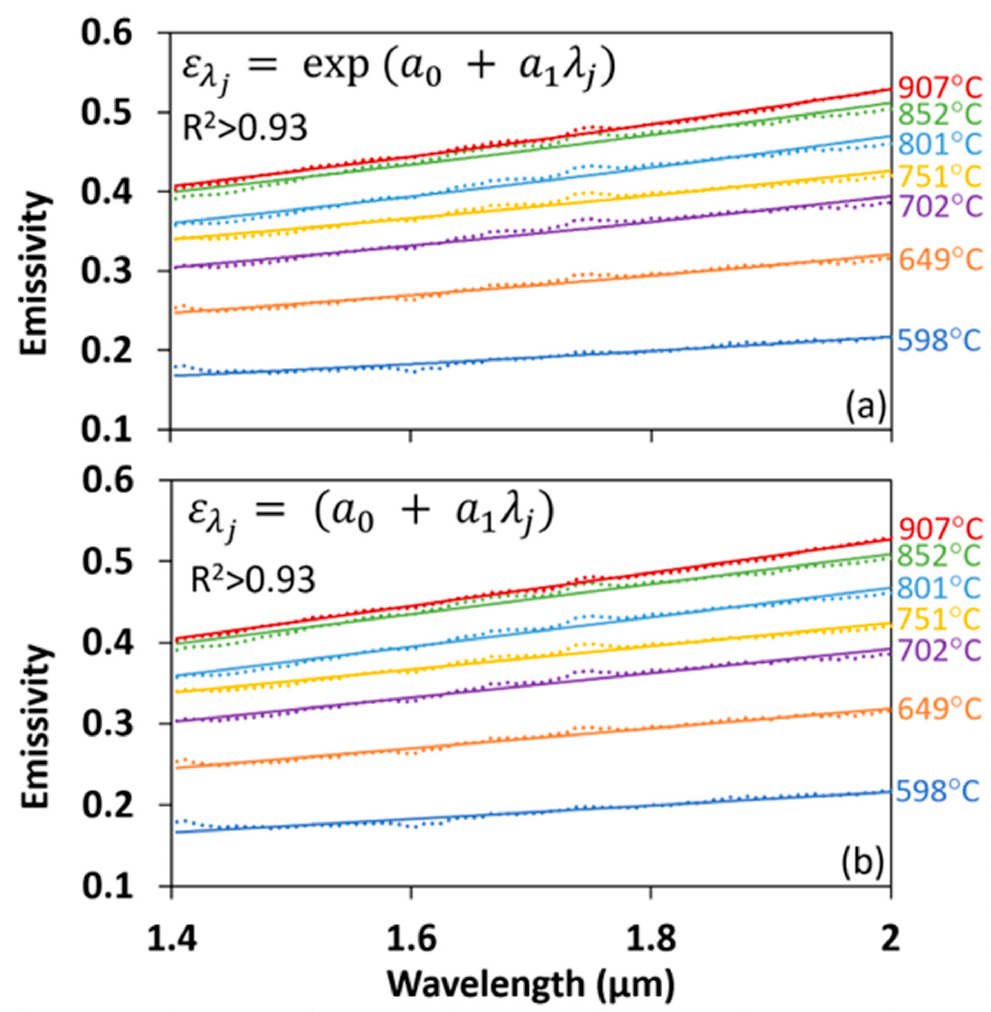
Figure 1. Measured emissivity (dotted curves) of a stainless-steel IC-engine valve and fits (solid curves) using a first-order ( m = 1) ( a ) exponential and ( b ) polynomial emissivity model.